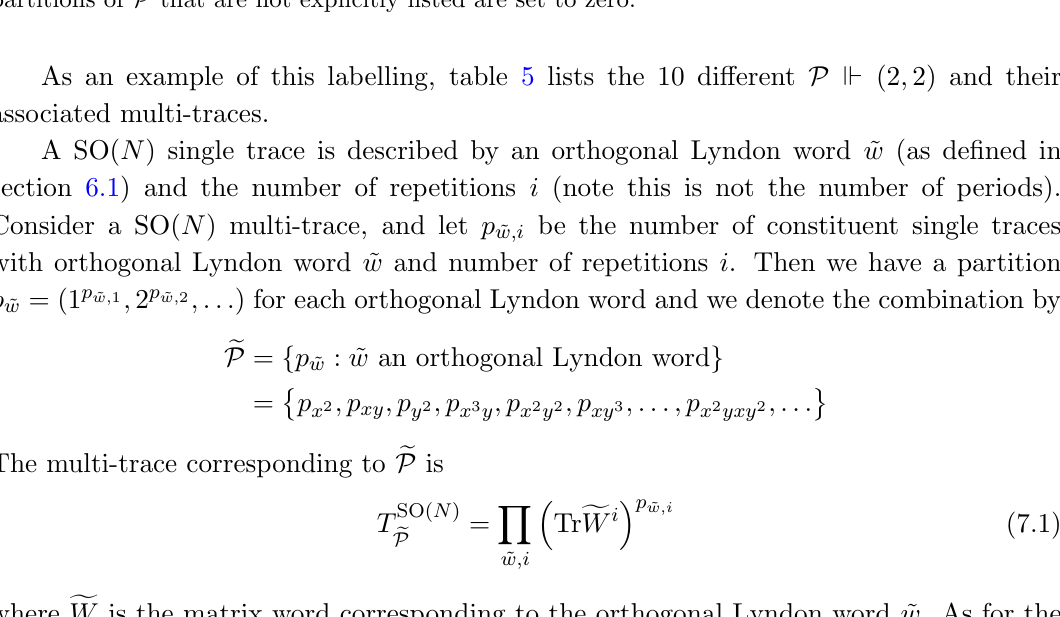
Table 5 . The 10 di(cid:11)erent U( N ) multi-traces at n = m = 2 along with their labels. Any constituent partitions of P that are not explicitly listed are set to